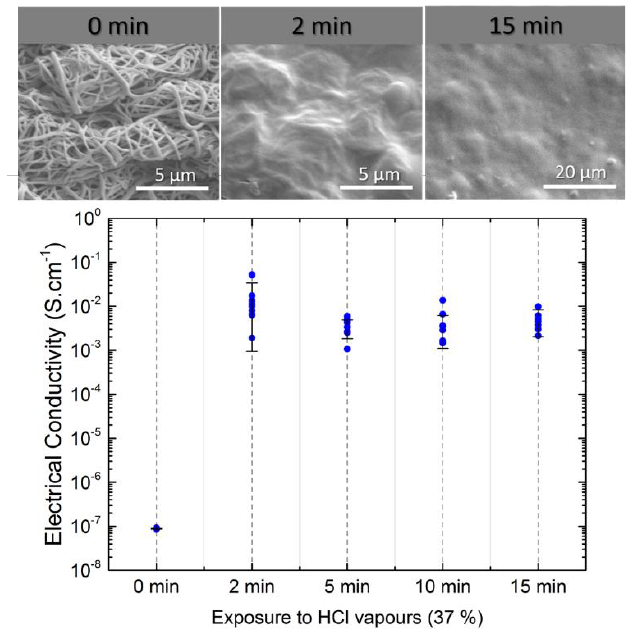
Figure 3. SEM micrographs of the membranes before and after exposure to HCl vapours (0, 2 and 15 min) and electrical conductivity measurements for every exposure time performed (0, 2, 5, 10 and 15 min).